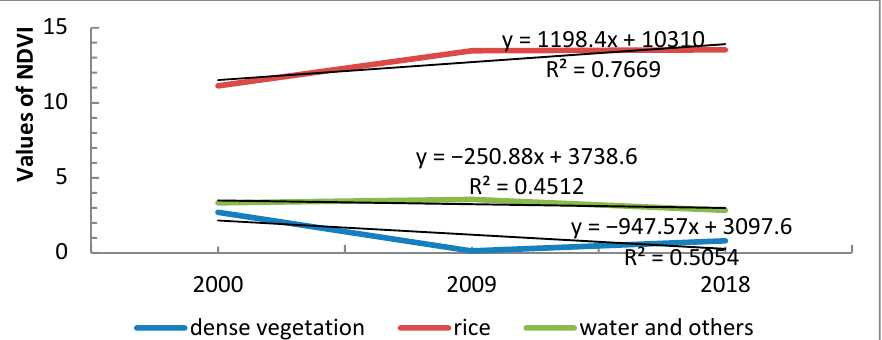
Figure 3. NDVI of rice cultivated land, dense vegetation and water in the Fogera floodplain between 2000–2018.